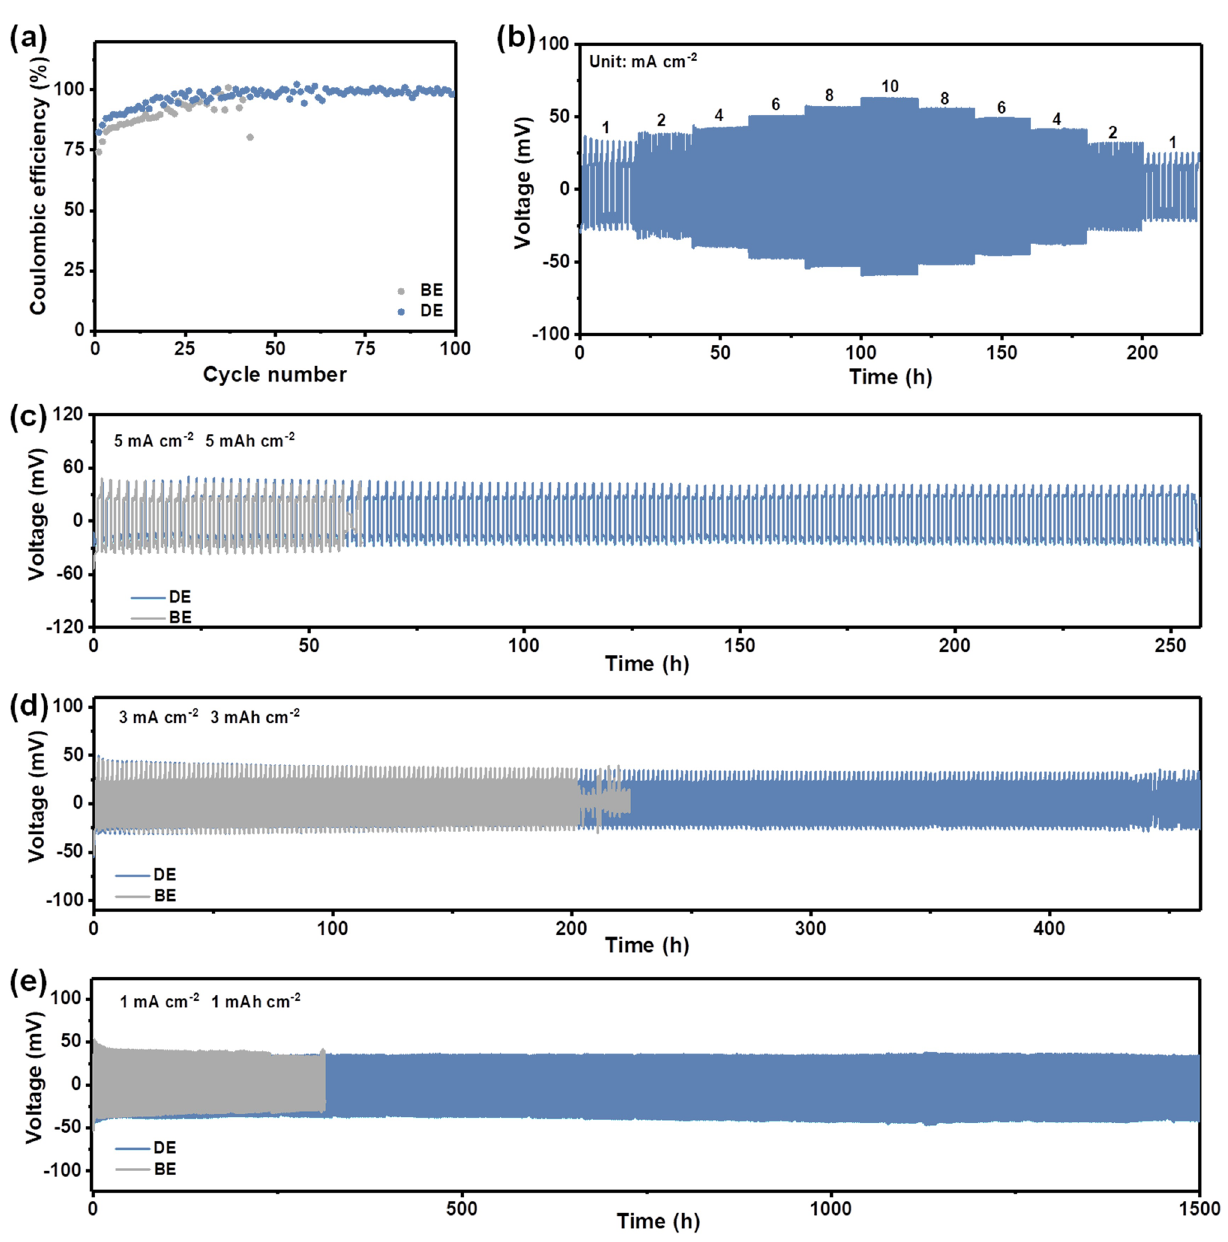
Fig. 4 Zn plating/stripping behaviors in different electrolytes. a Coulombic efficiency of Zn//Cu asymmetric cells at 2 mA cm −2 –1 mAh cm −2 . b Rate performance of Zn//Zn symmetric cell in DE. c‑e Long-term cycling performances of Zn//Zn symmetric cells at 5 mA cm −2 –5 mAh cm −2 , 3 mA cm −2 –3 mAh cm −2 , and 1 mA cm −2 –1 mAh cm